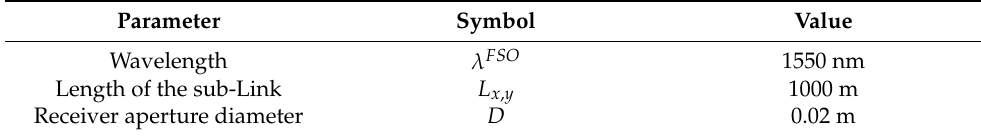
Table 2. FSO sub-link parameters.